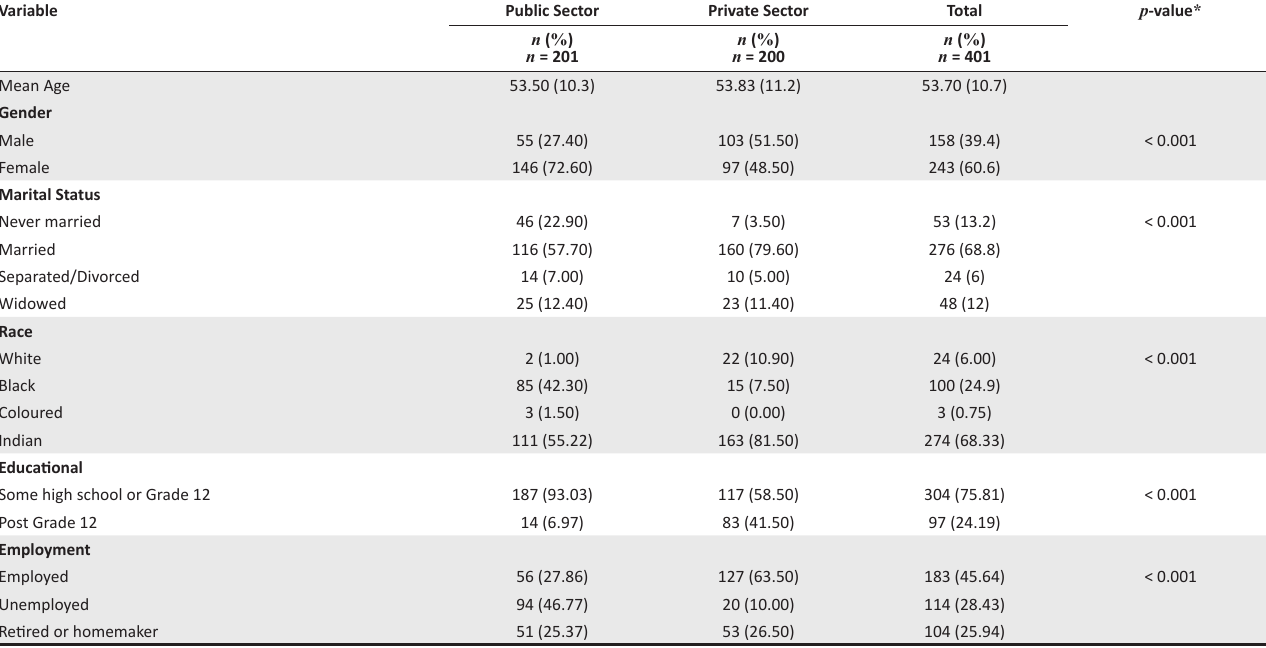
TABLE 1: Demographic characteristics of the study sample by health sector.